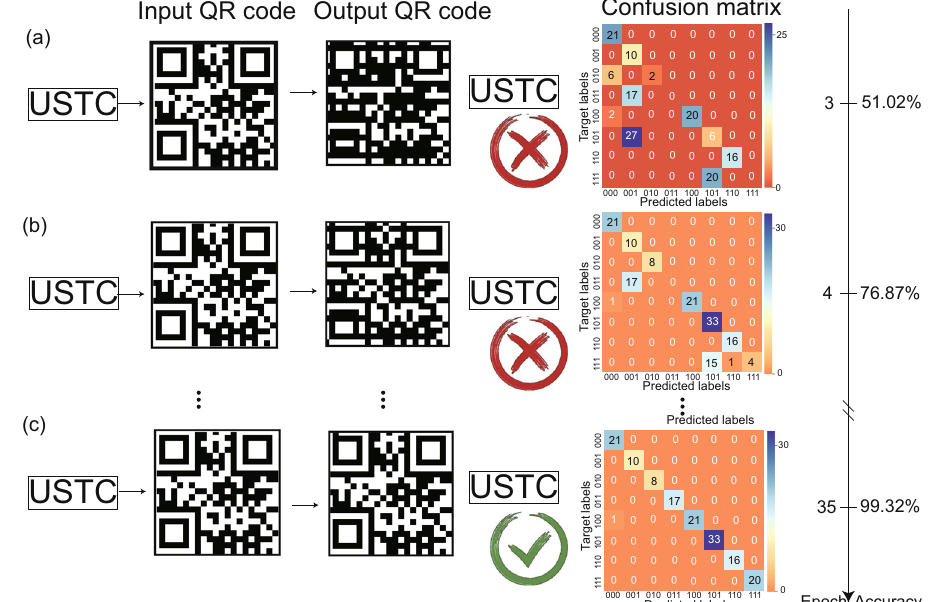
Fig. 3 Reconstruction of the QR code after different epochs of training of the deep learning model. After a 3 epochs, b 4 epochs, and c 35 epochs of training, the accuracies of our deep learning model are 51.02%, 76.87%, 99.32%, respectively, as determined from the confusion matrices (last column). The y -axis is the ground truth and the x -axis represents the predictions of the deep learning model. The colour bar and the numbers indicate the counts. If the prediction is correct, then the corresponding diagonal term in the confusion matrix increases by 1. If incorrect, then the nondiagonal element increases by 1.